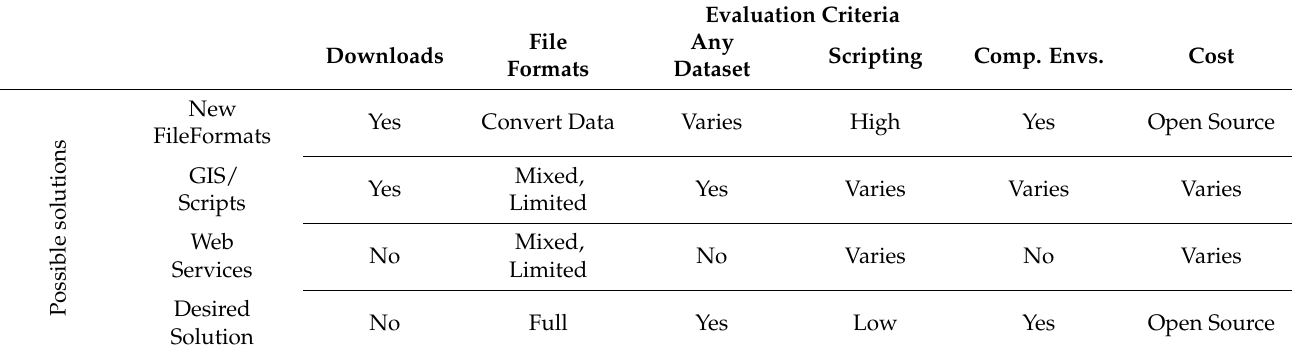
Table 1. Evaluation of Solution Paths. Evaluation